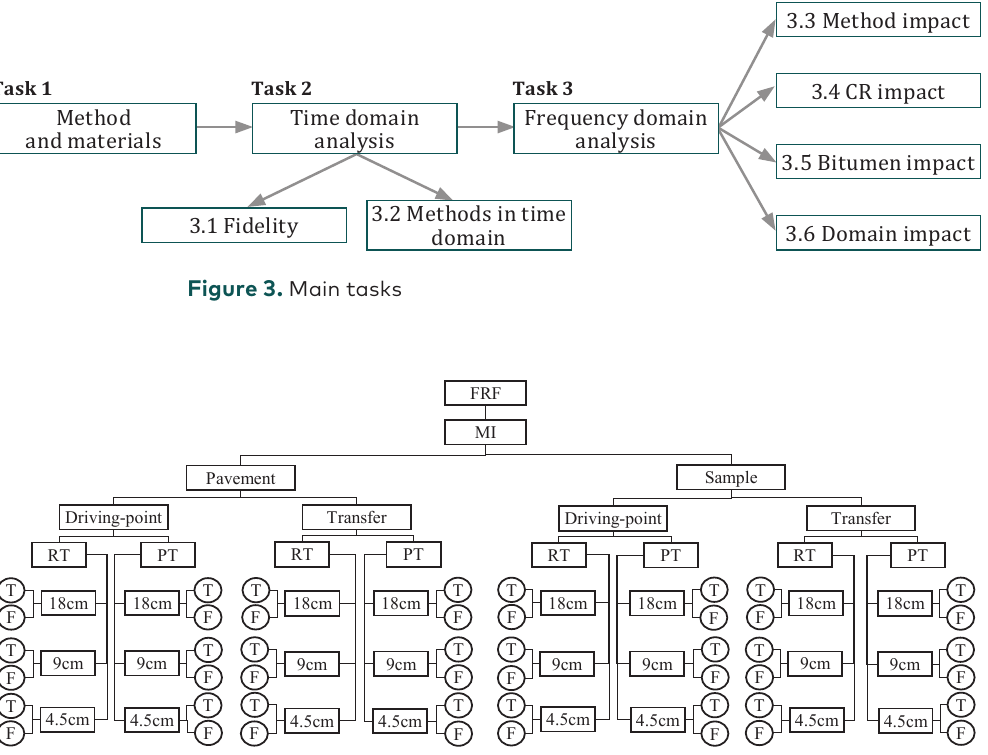
Task 1 Task 2 Task